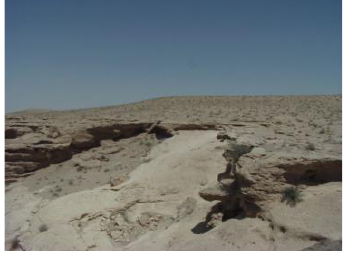
Figure 9. Collapsed Palaeolithic abris at Jebel Bishri. Photo: J.-P. Matar